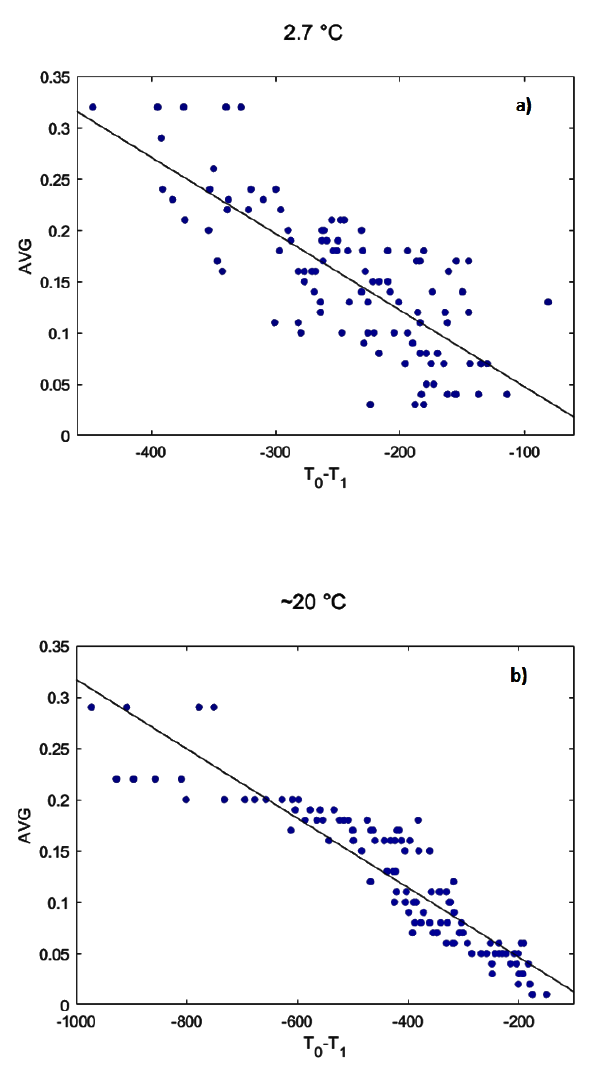
Figure 2. The correlation between endothelial cells (mean di ff erence pre- vs. post- interventions) and the average amount of ultrasound used (AVG) at: ( a ) BSS at 2.7 ◦ C and ( b ) BSS ~20 ◦ C.